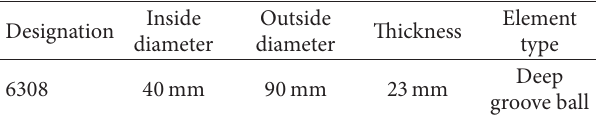
Table 2: Bearing structure information.